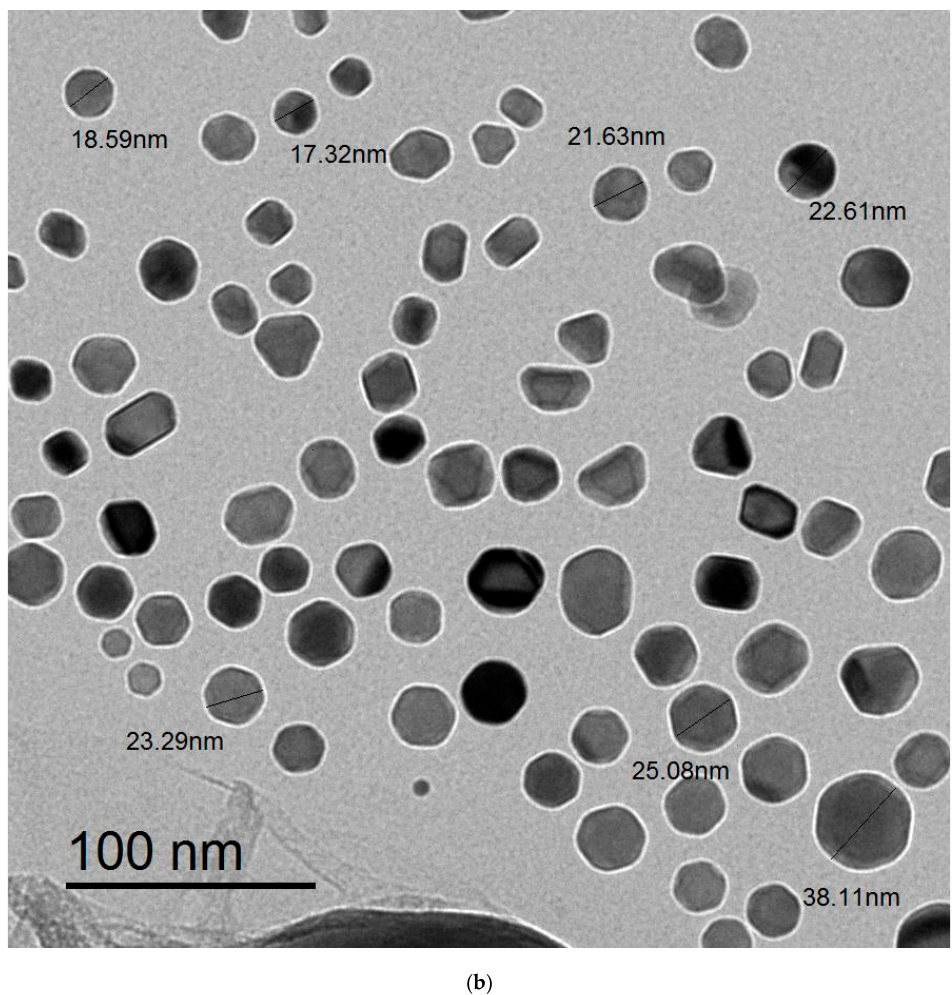
Figure 3. Transmission electron microscopic (TEM) image of biosynthesis: Ulva/nanocellulose ( a ) and Ulva/Ag/cellulose nanocomposites ( b )